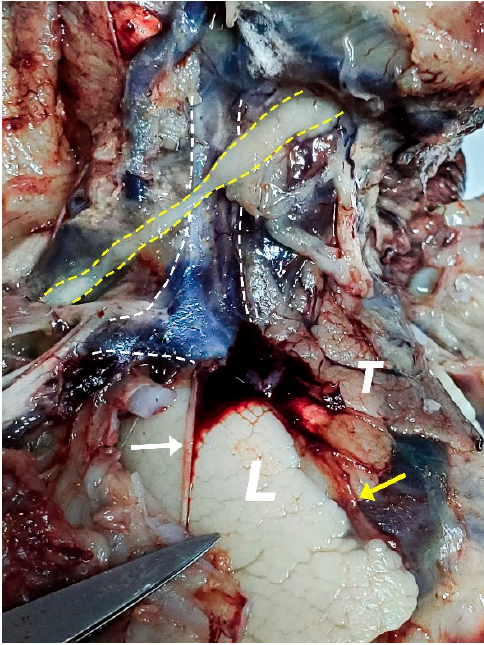
Figure 8. Neck, thoracic cavity, right-anterior view; platysma and SCM were removed. White dashed lines highlight the right internal jugular vein, right subclavian vein, and right brachiocephalic vein. Dilation of the right internal jugular vein and the right subclavian vein. The conflation of the two into the right brachiocephalic vein is wider in caliber as well. Yellow dashed lines highlight the omohyoid muscle, running over the internal jugular vein. L—right lung; T—thymus; White arrow—vagus nerve; Yellow arrow—phrenic nerve.